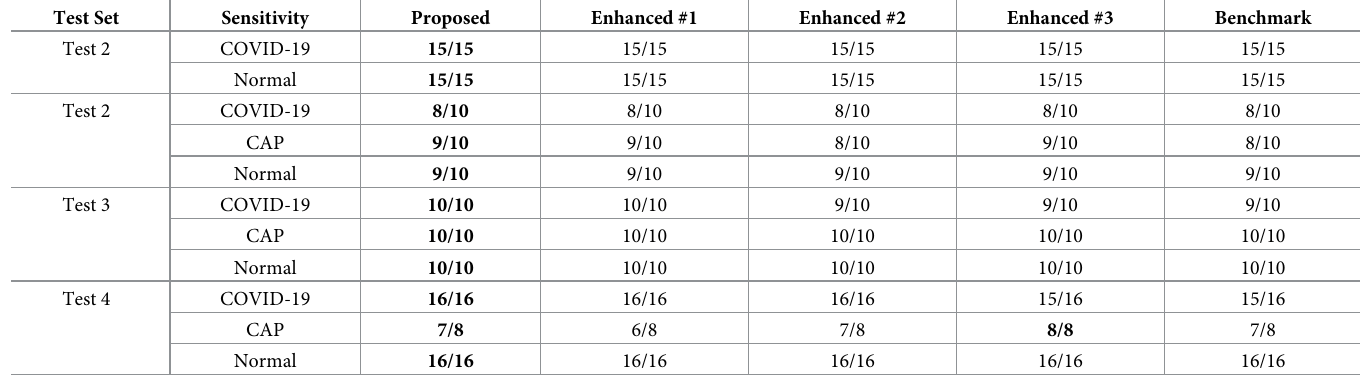
Table 4. The ratio of correctly classified cases over total cases in the associated class obtained for the proposed model, the benchmark model, and the partially enhanced